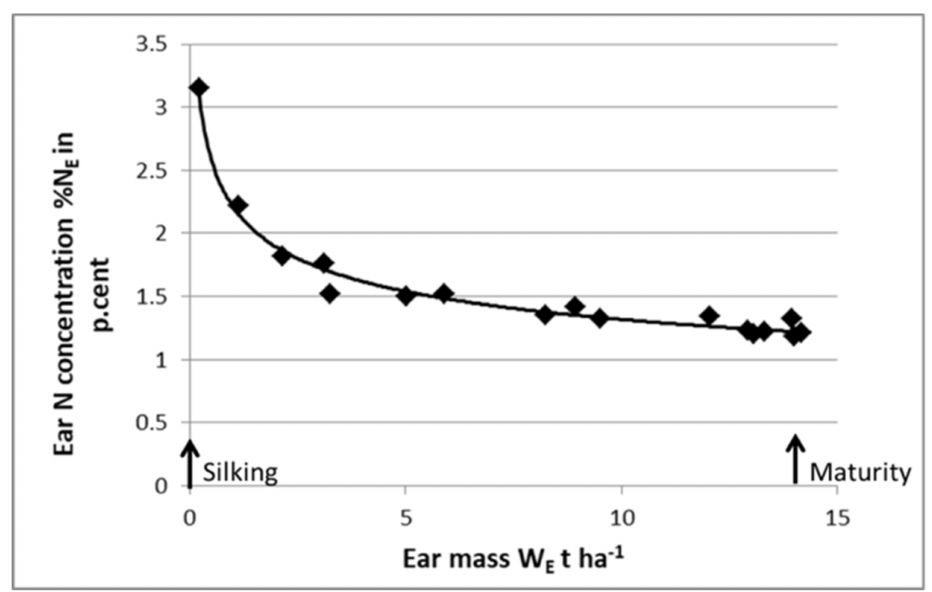
Figure 8. Curve for the critical N dilution in the ear organ for maize crop determined from silking to maturity: %N E = 2.3 W E − 025 . %N E = ear N concentration, W E = ear biomass. Data redrawn from Pl é net and Lemaire [22].